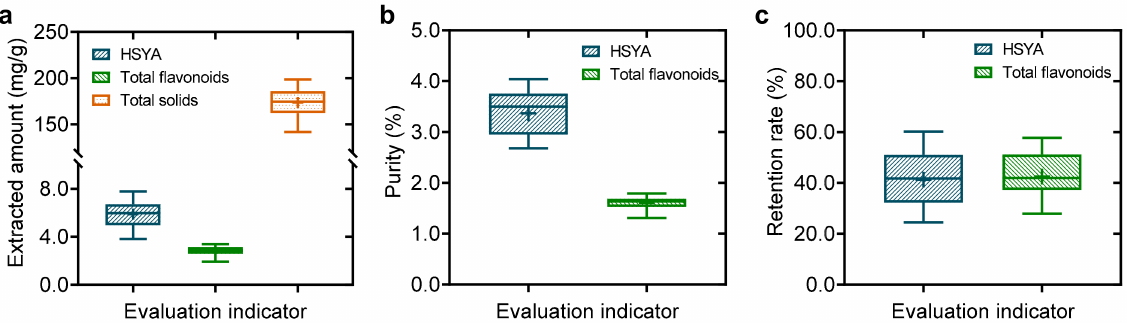
Figure 3. Box diagram of extracted amount ( a ), purity ( b ), retention rate ( c ). Data were from Table A1, n = 28. The upper and lower parts of the box are the 25% and 75% percentiles, respectively, the “ +” represents the mean value, and error lines represent the maximum and minimum values of the 28